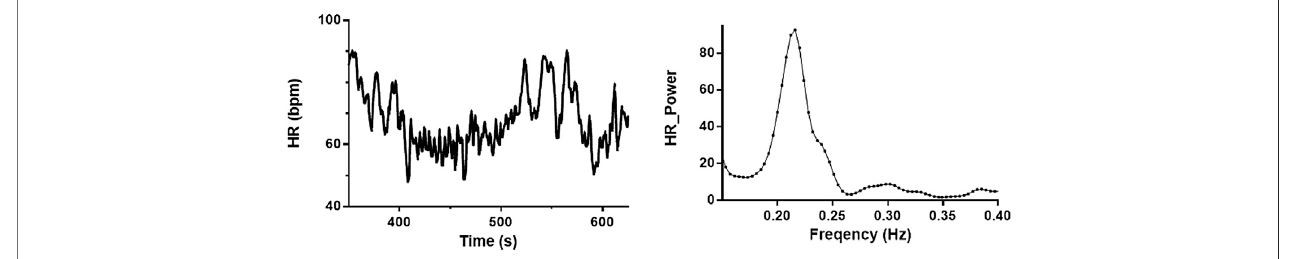
FIGURE 1 | Baseline recording of heart rate and power spectrum of high-frequency interval. Heart rate (HR) recording from one subject during spontaneous breathing (left) and power spectra from the same recording (right). Respiratory sinus arrhythmia (RSA) is estimated as the area under the curve of the power spectra (0.15 – 0.4 Hz).